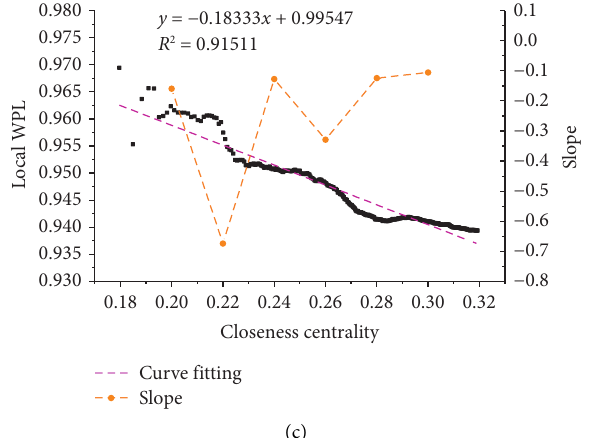
Figure 11: Correlation analysis of road centrality and local WPL: (a) betweenness centrality; (b) straightness centrality; (c) closeness centrality.